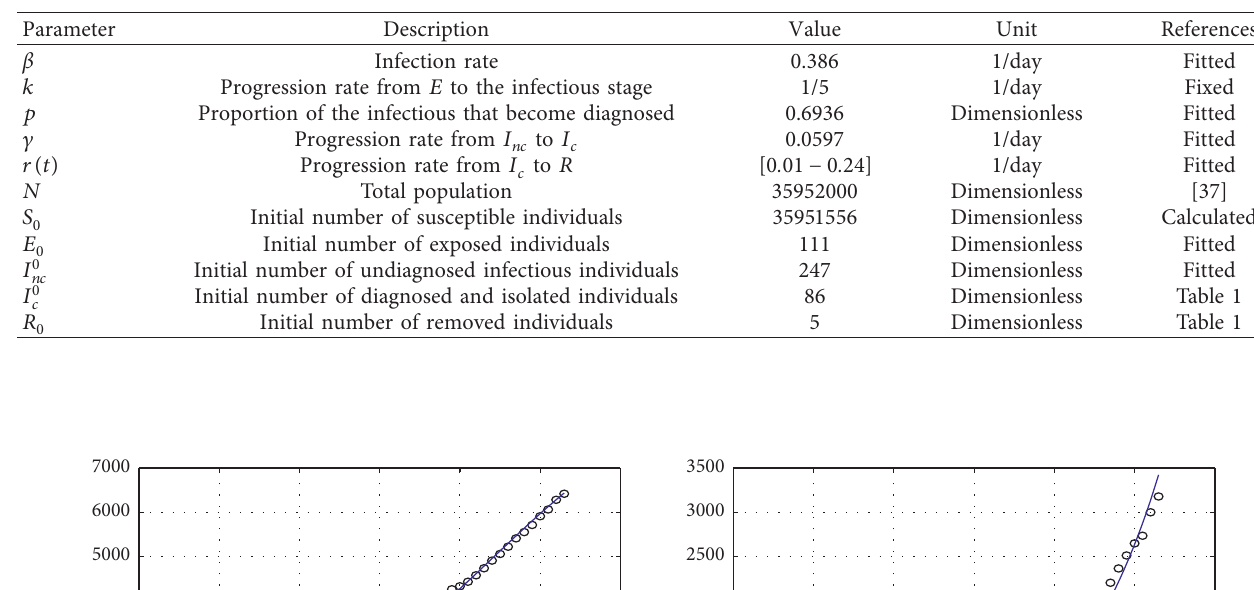
Table 2: Parameters and initial conditions.